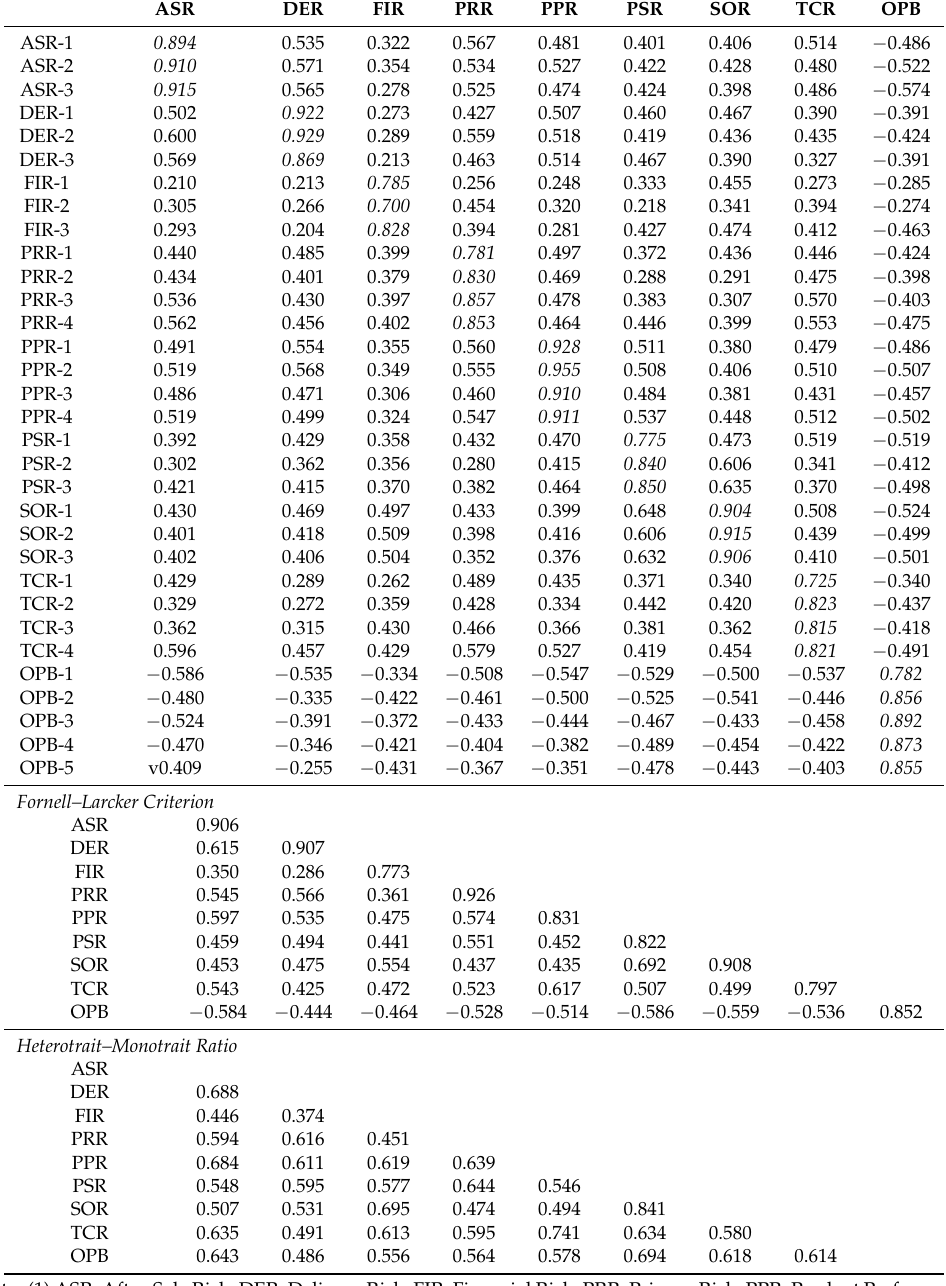
Table 5. Outer model loading and